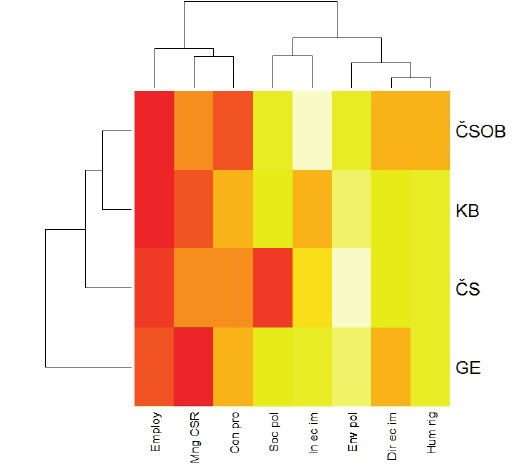
Fig. 2 - Heatmap clusters. Source: